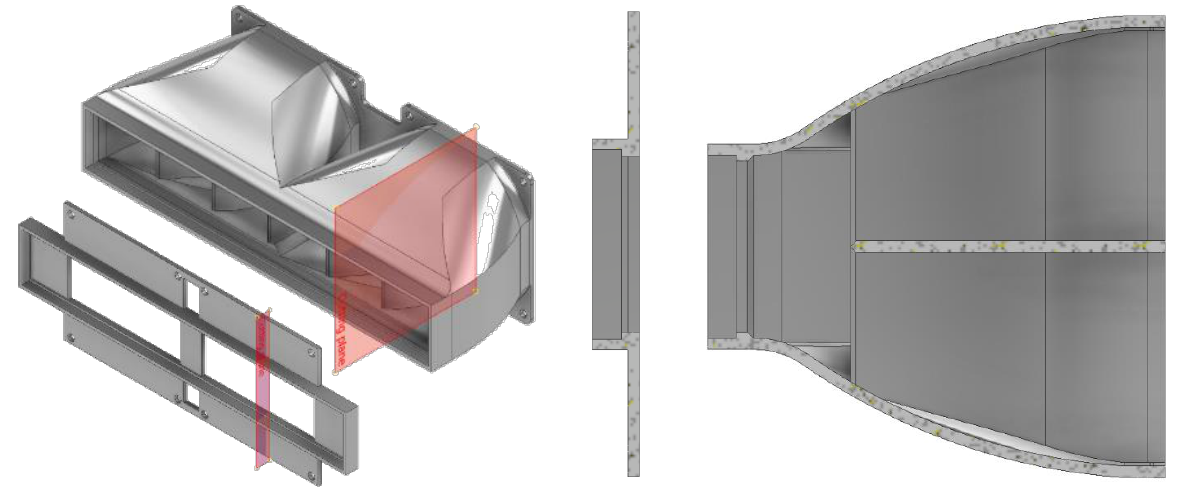
Fig. 3. Original and optimized diffuser shape for air outlet from the fuel cell with the indicated cutting plane on the left. Cross section of the original and optimized diffuser on the